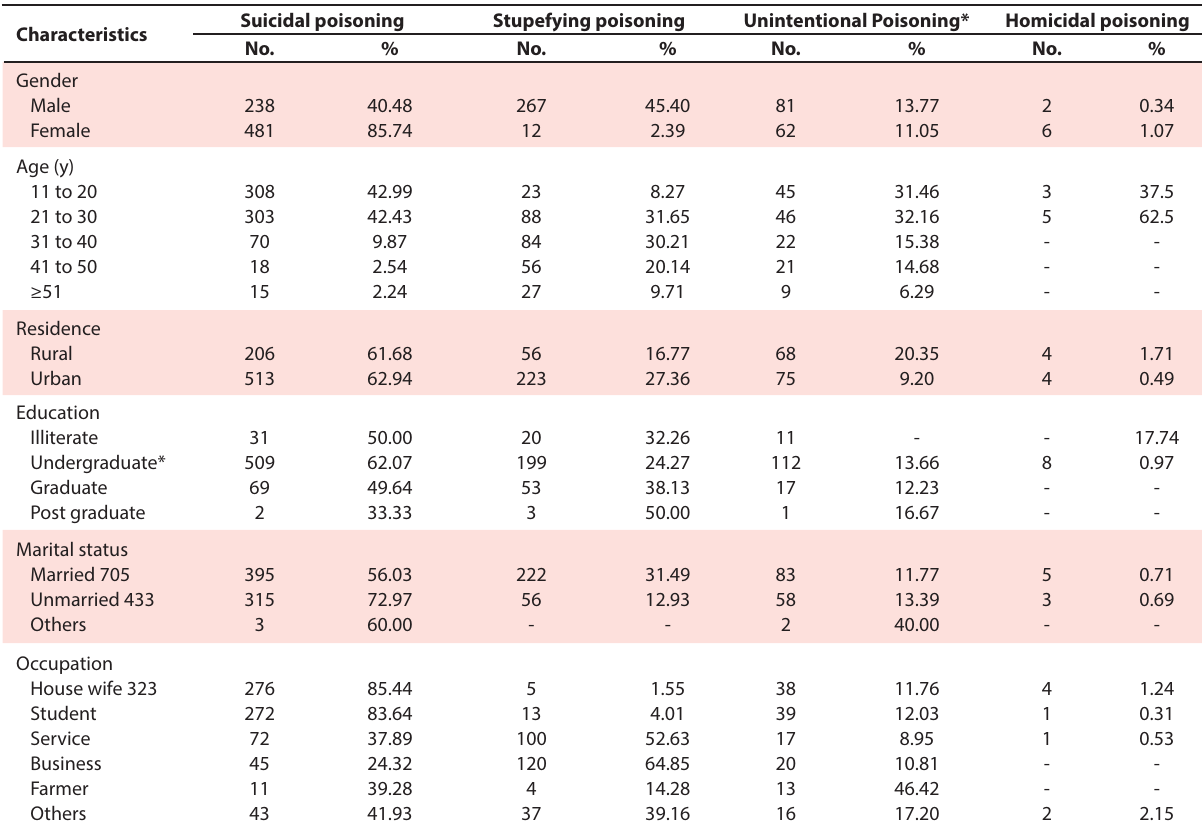
Table 1. Sociodemographic characteristics of the patients according to mode of poisoning Characteristics